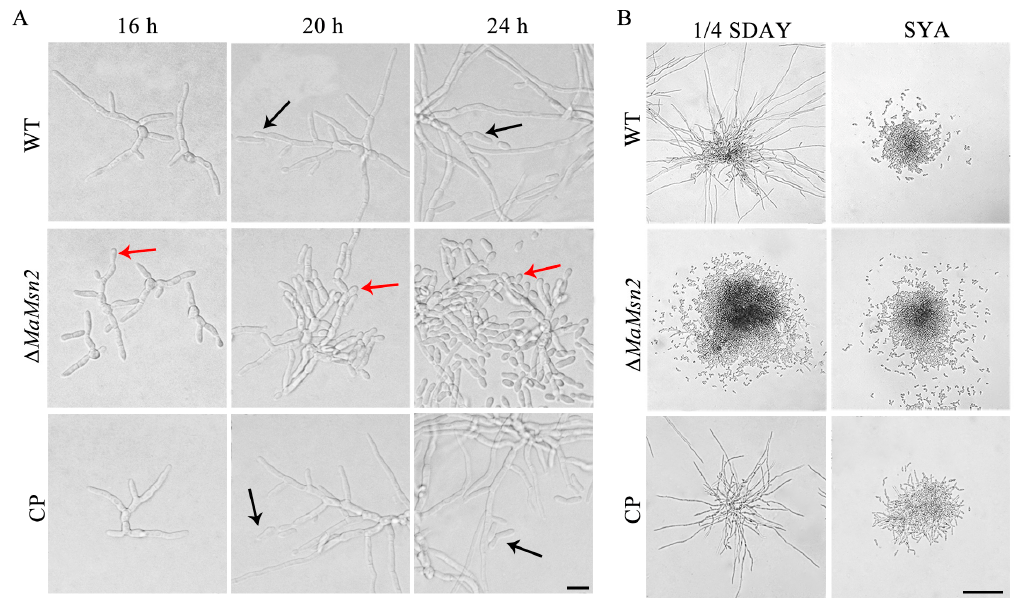
Figure 4. The conidiation phenotype of Δ MaMsn2 . ( A ) The conidiation of Δ MaMsn2 on 1/4 SDAY medium at 16, 20 and 24 h. Scale bars indicate 5 μ m. Black arrow: normal conidiation; Red arrow: microcycle conidiation. ( B ) The conidiation phenotype of Δ MaMsn2 on 1/4 SDAY and SYA media for 32 h. Scale bars indicate 100 μ m.